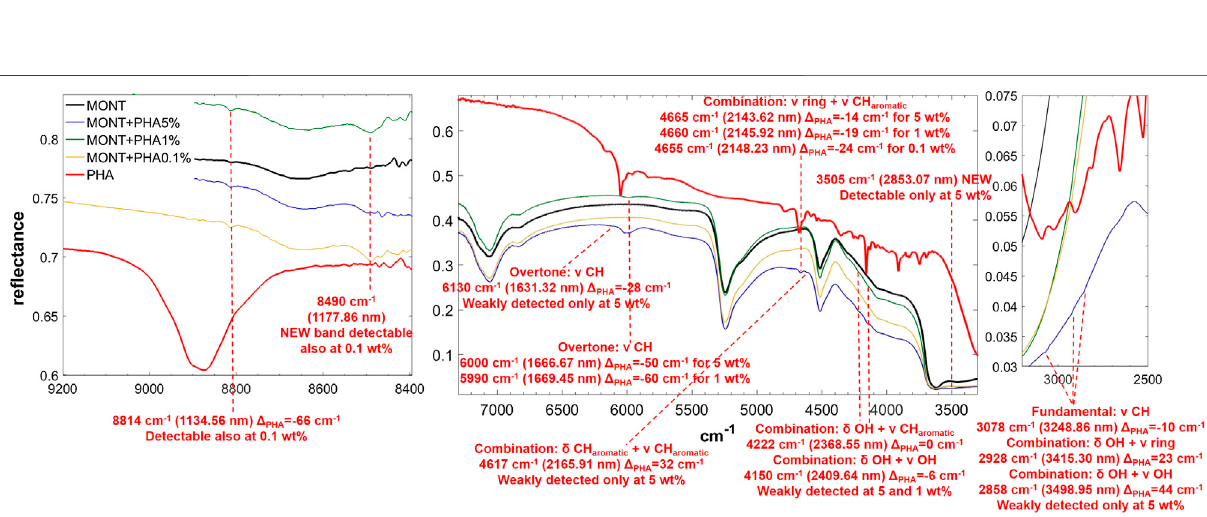
Frontiers in Astronomy and Space Sciences |